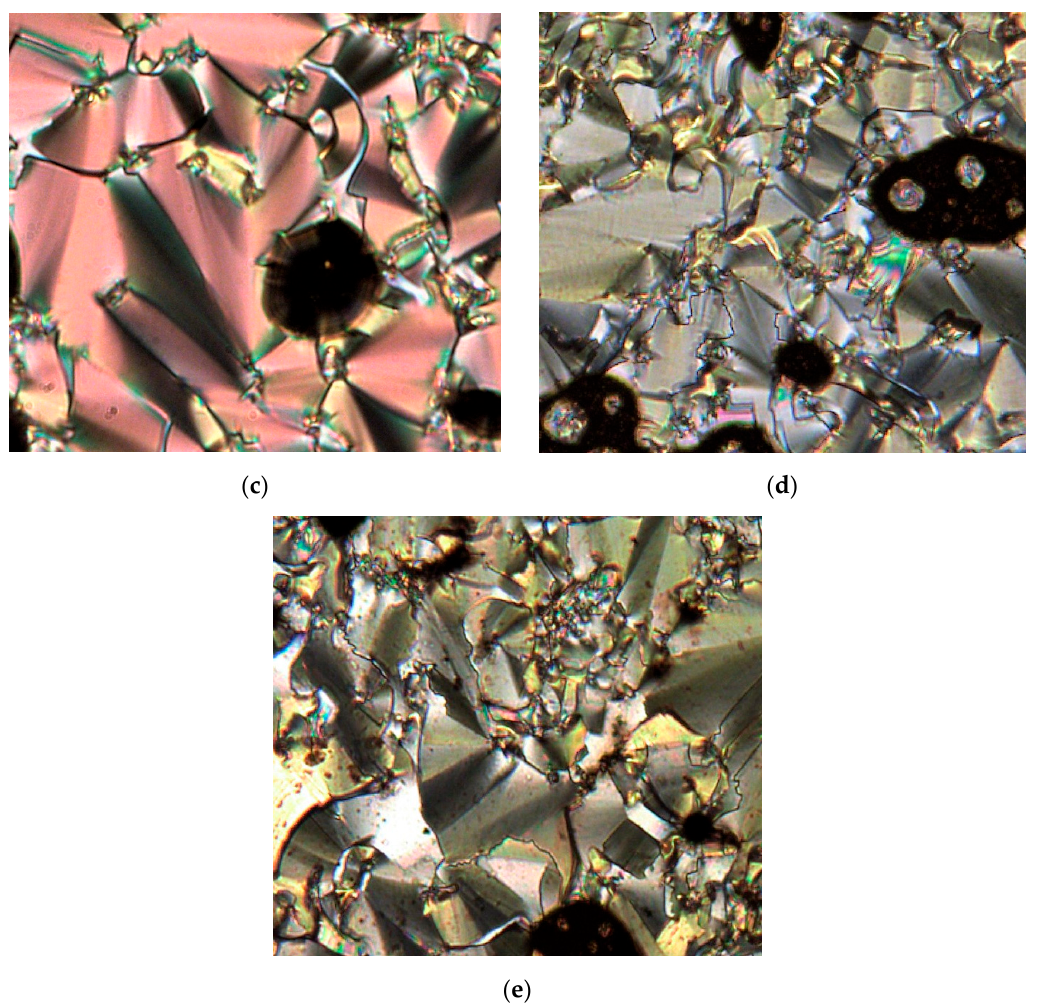
Figure 14. The optical photomicrographs of broken focal-conic fans of SmC phase in the cooling cycle for ( a ) 8a at 150.36 ° C; ( b ) 8b at 148.75 ° C; ( c ) 8c at 140.55 ° C; ( d ) 8d at 141.10 ° C, and ( e ) 8e at 130.51 ° C (Magnification: 20 × 0.25).